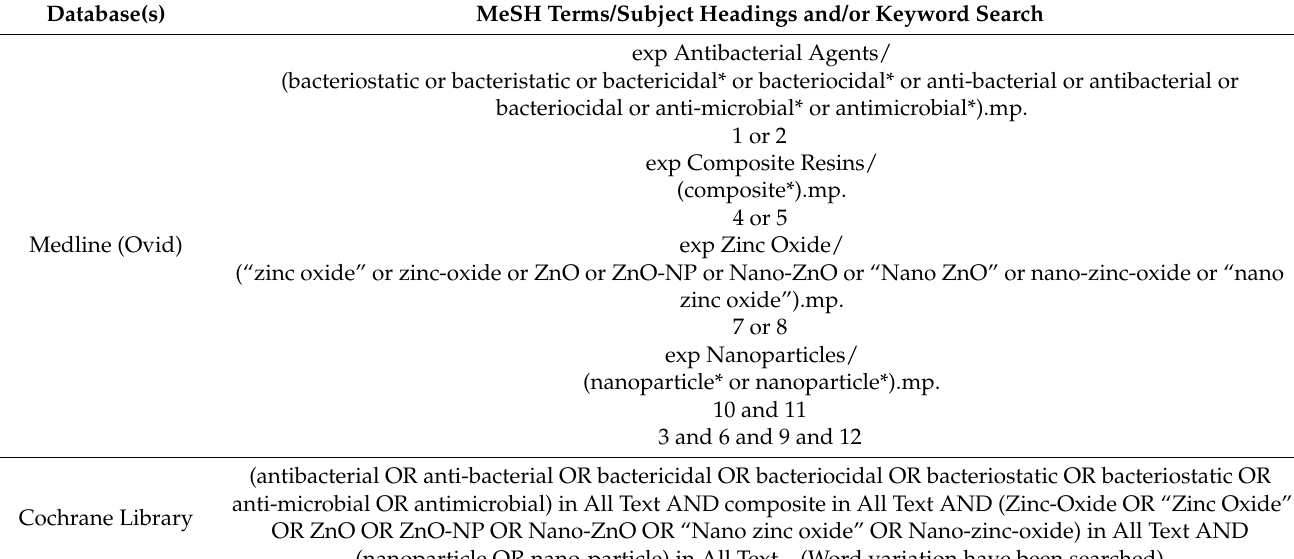
Table 1. Search strategy for databases